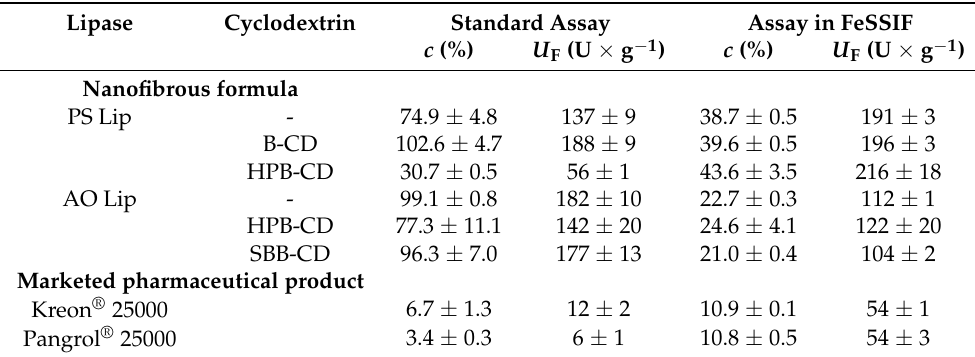
Marketed pharmaceutical product Kreon ® 25000 6.7 ± 1.3 Pangrol ® 25000 1 To Tris buffer (900 µ L, pH = 8.0, 50 mM, 0.4% ( w / v ) Triton X100, 0.1% ( w / v ) gum arabic) a solution of p -NPP (100 µ L, 16.5 mM, dissolved in 2-propanol) was added. To initiate the test reactions 150 µ L of lipase solution was added, i.e., 5 mg nanofibrous lipase formulation, containing 10% ( w / w , relative to the sum mass of the fibers) lipase and CD in the appropriate lipase:CD mass ratio (PS Lip:CD = 1:1, AO Lip:CD = 1:3 ( w / w )), dissolved